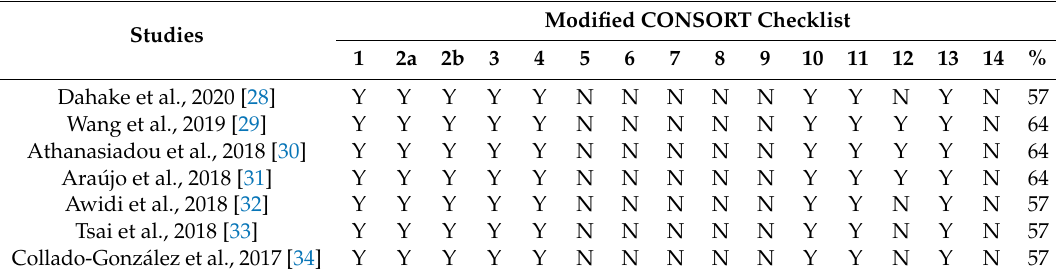
Table 5. Quality assessment